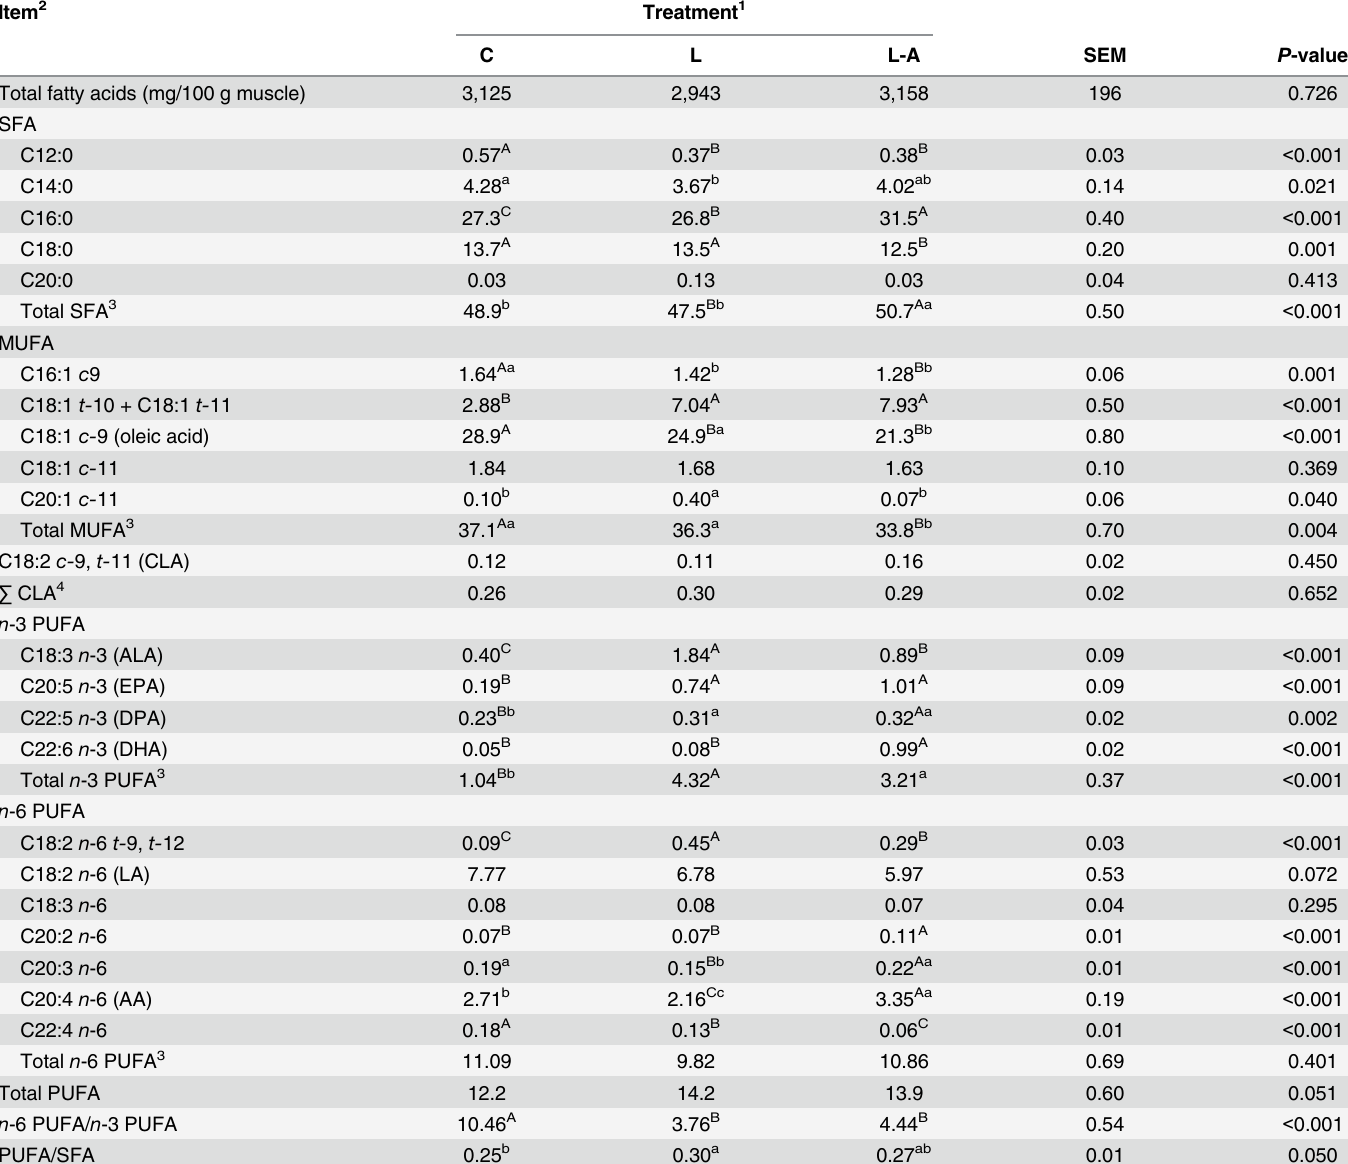
Table 5. Effects of addition of linseed or linseed and marine algae to the diet on fatty acid composition (g/100 g of total identified fatty acid methyl esters) in intramuscular adipose tissue of Navarra breed lambs. Item